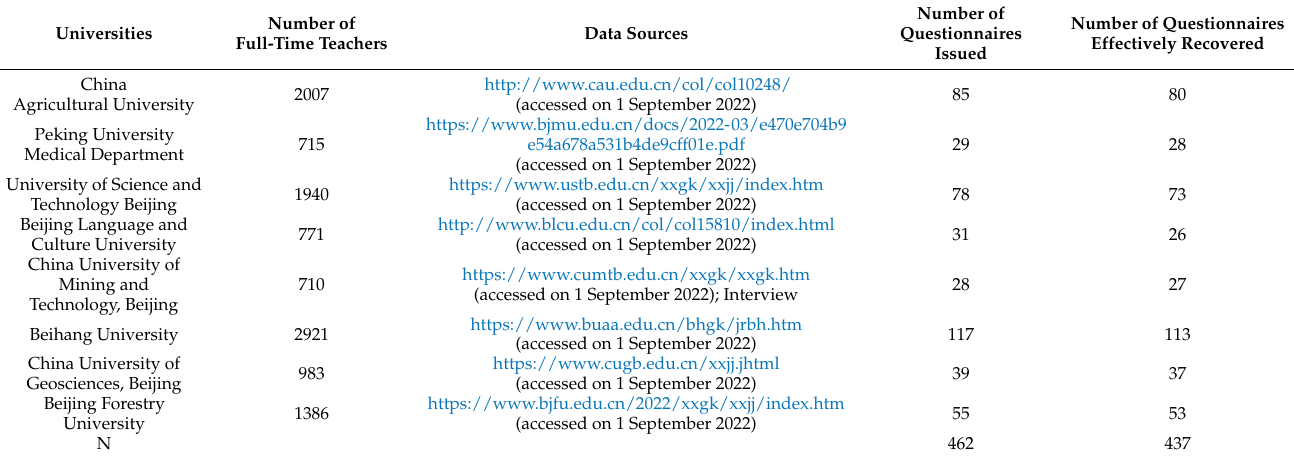
Table A1. Number of questionnaires issued and